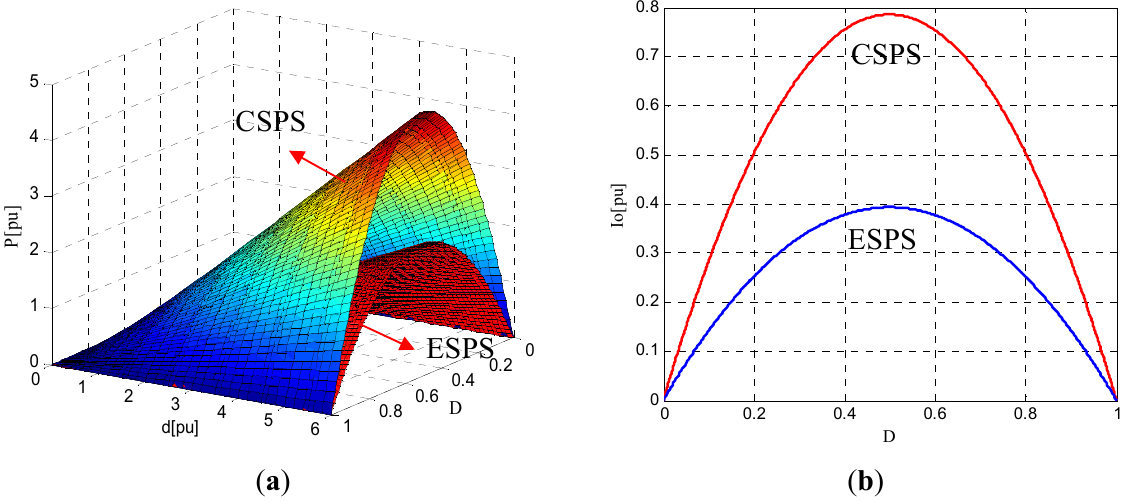
Figure 5. Comparative analysis of transmission power. ( a ) 3-D curve of normalized transmission power; ( b ) 2-D curve of normalized output